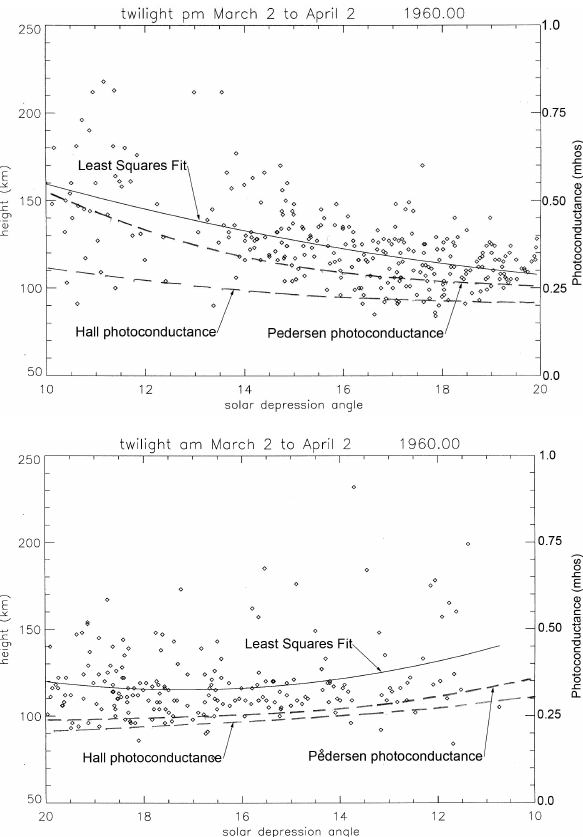
Fig. 5. ( a ) Same as Fig. 4a, except for all eight days in March and April of 1960. A second order polynomial least squares fit to the data is shown along with the conductance as a function of solar depression angle. ( b ) Same as Fig. 5a, except for morning